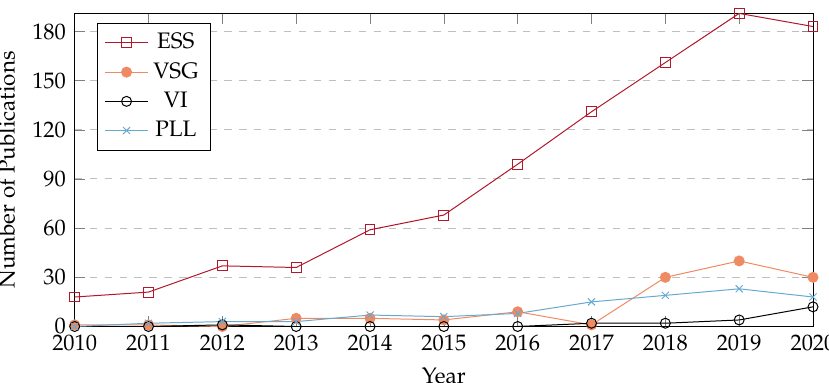
Figure 7. Trends in frequency-control technologies in microgrids. ESS—energy storage system, VSG—virtual synchronous generator, VI—virtual inertia, PLL—phased